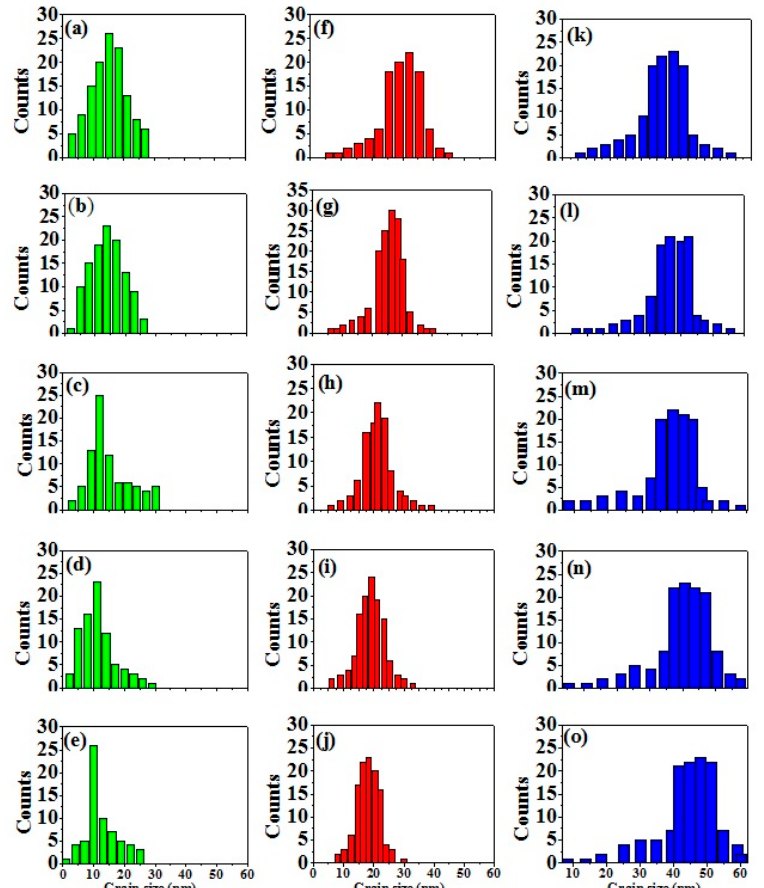
Figure 3. Grain size distribution of bottom layer Mo films deposited at different bottom layer sputtering pressures: ( a ) 0.4 Pa, ( b ) 0.6 Pa, ( c ) 0.8 Pa, ( d ) 1.0 Pa, ( e ) 1.2 Pa, Mo bilayer films deposited at different bottom layer sputtering pressures: ( f ) 0.4 Pa, ( g ) 0.6 Pa, ( h ) 0.8 Pa, ( i ) 1.0 Pa, ( j ) 1.2 Pa and Mo bilayer films annealed at different temperatures: ( k ) 100 ◦ C, ( l ) 150 ◦ C, ( m ) 200 ◦ C, ( n ) 300 ◦ C, and ( o ) 400 ◦